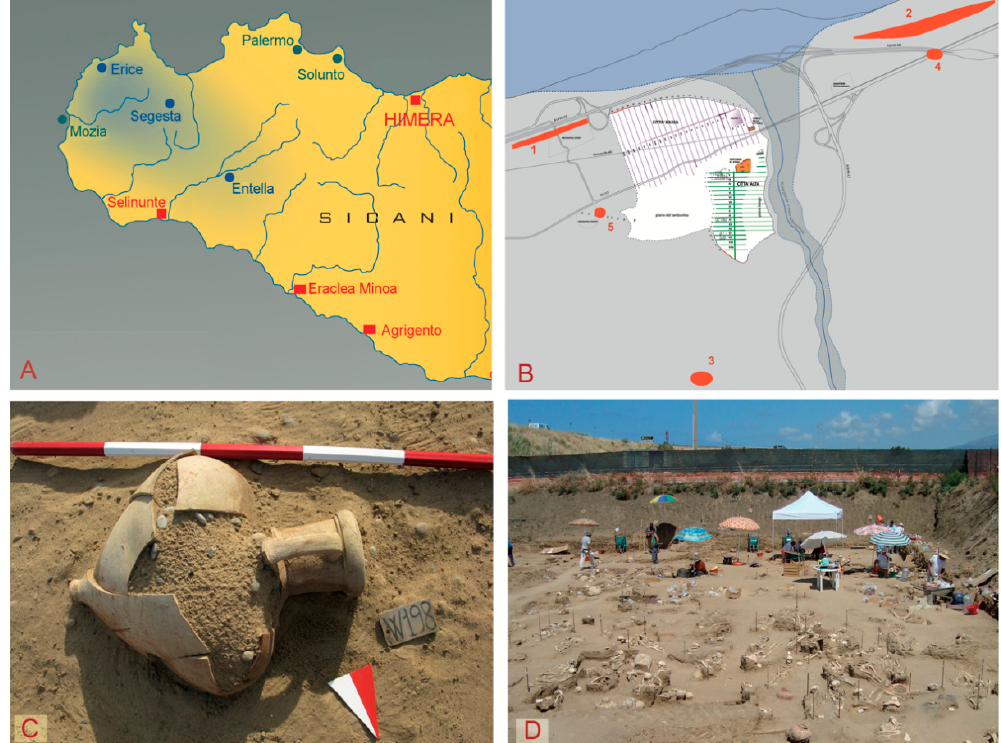
Figure 1. ( A ) Geographical localization of Himera; ( B ) planimetry of Himera; ( C ) western Greek amphora produced in Himera; ( D ) excavations in the western necropolis of Himera.